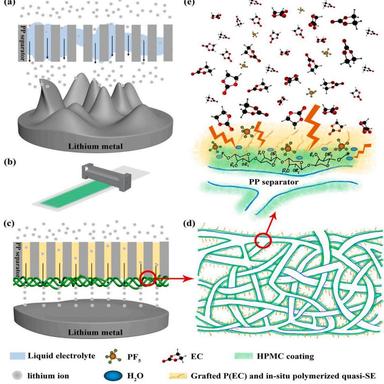
Schematic representation of (a) the Li electrodeposition process with commercial PP, (b) the facile doctor-blade casting approach, (c) the Li electrodeposition process with the HPMC-induced in-situ SE, (d) effective HPMC coating and permeation of porous PP structure, and (e) in-situ polymerization and graft of EC with HPMC coating and the anchored H2O, and the corresponding in-situ quasi-SE.